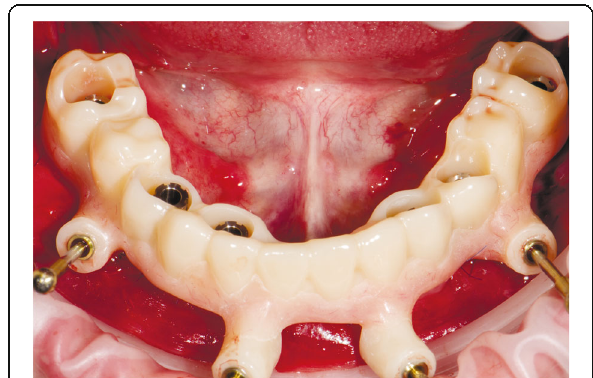
Fig. 14 Interim prosthesis positioned and fixed with the same pins of the surgical guides